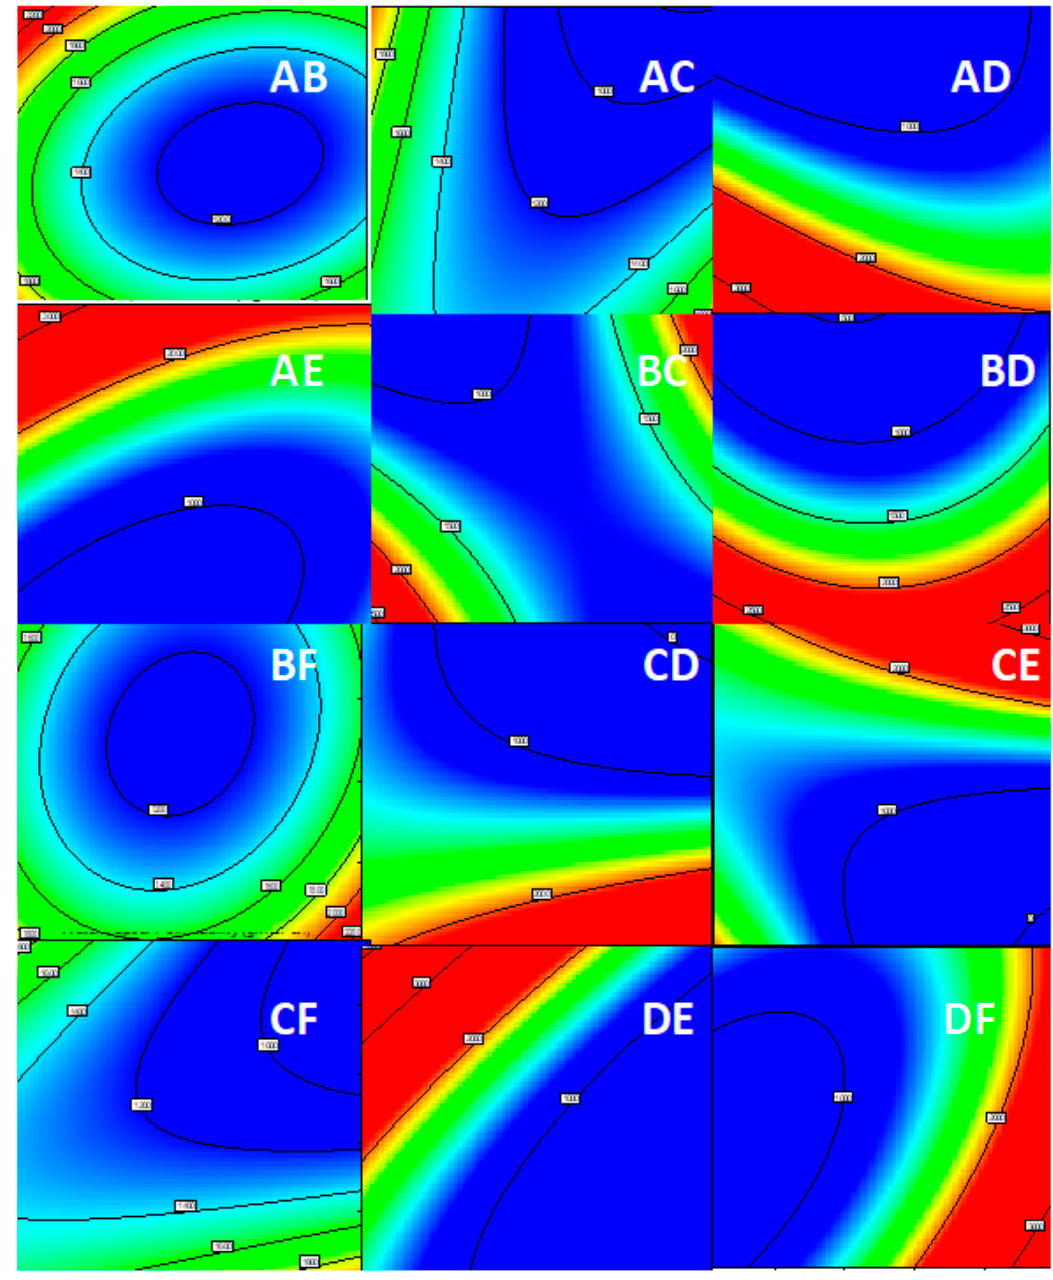
Figure 7. E ff ects of industrial process parameters on response water vapor permeability: ( A —fabric weight, B —dye concentration, C —hydrophobic concentration, D —temperature, E —pressure and F —the type of the hydrophobic compound). Interactions shown are: ( AB , AC , AD , AE , BC , BD , BF , CD , CE , CF , DE , DF